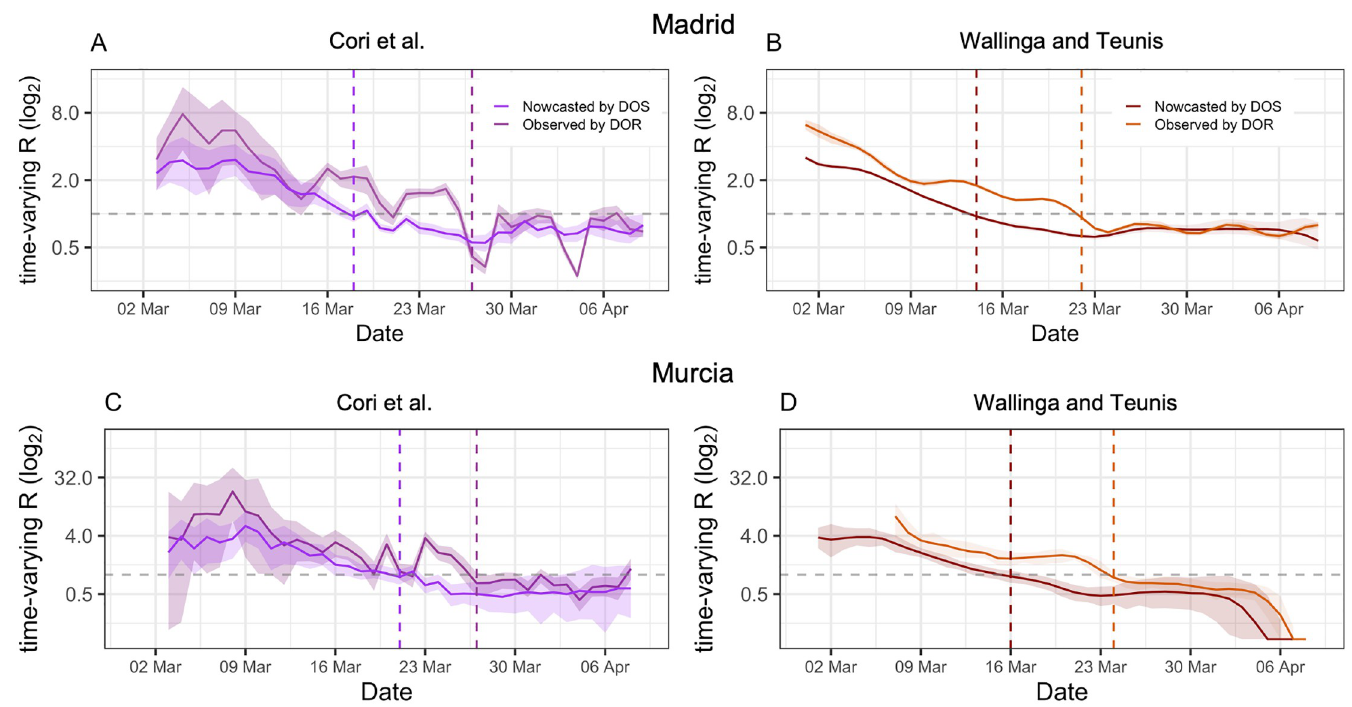
Fig 3. Reproductive numbers estimated from nowcasted cases by DOS vs observed cases by DOR using Cori et al (A,C) and Wallinga and Teunis (B,D) approaches for Madrid and Murcia, March 1-April 09, 2020. Showing the reproductive numbers estimated for Madrid (A,B) and Murcia (C,D). Estimates were computed using Cori et al (A,C) or Wallinga and Teunis (B,D) approaches and either nowcasted cases by DOS vs observed cases by DOR. A generation interval of mean 5 (1.9 SD) was used. Log2scale for the y-axis is used to facilitate